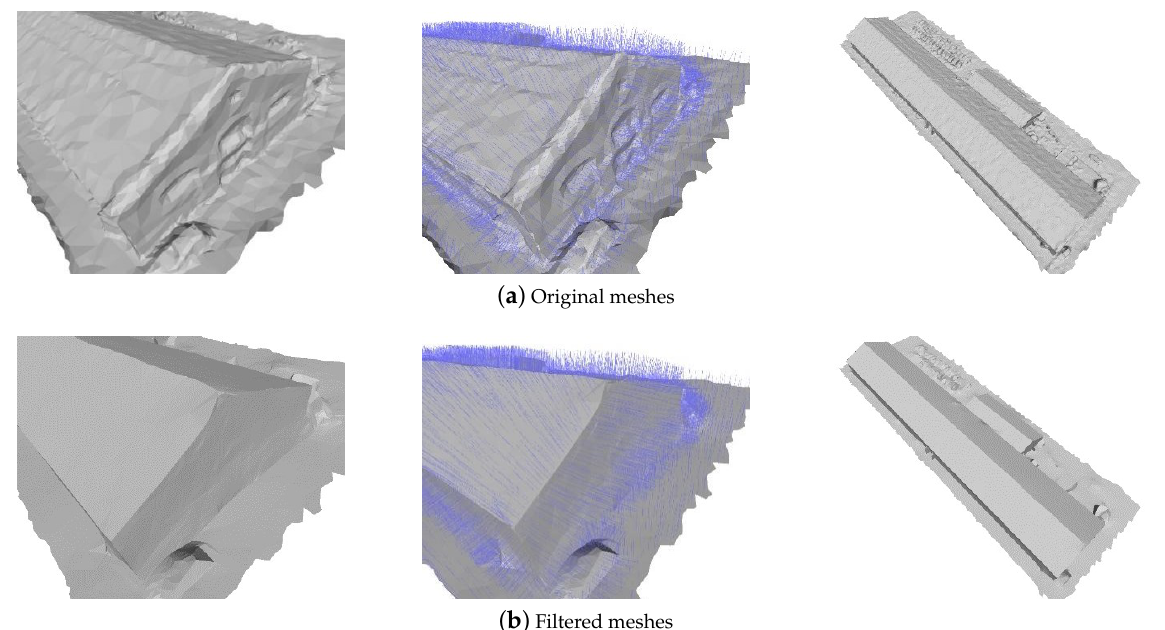
Figure 2. Comparison of the meshes before and after mesh filtering. ( a ) Original meshes. ( b ) Filtered meshes. (Left to Right) Partial models, face normals, and overall